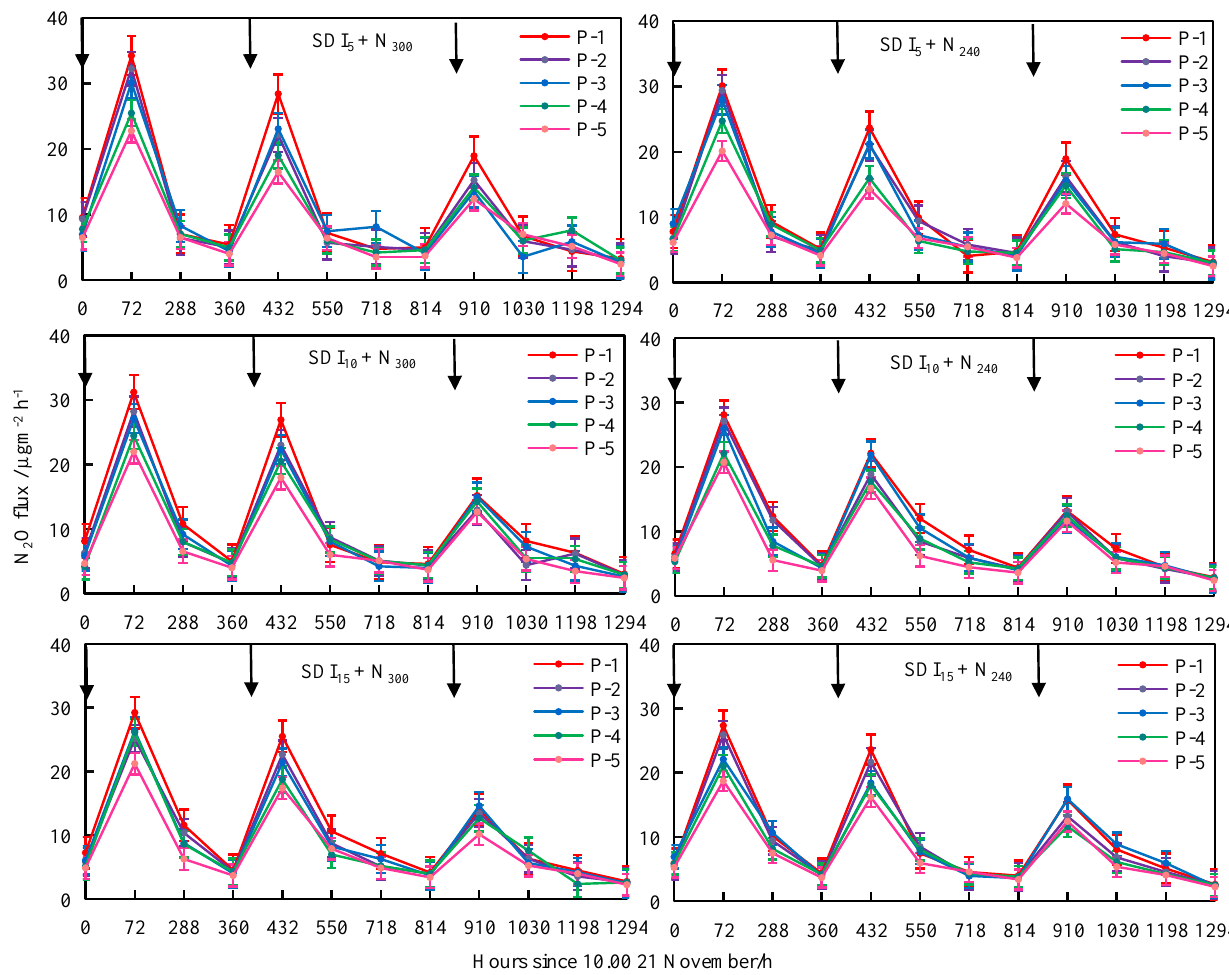
Figure 10. Trend of N 2 O flux under different SDI emitter depths over the entire experimental period. P-1, P-2, P-3, P-4, and P-5 represent chambers 1–5. Arrows represent water and fertilizer application events. Error bars represent standard error.